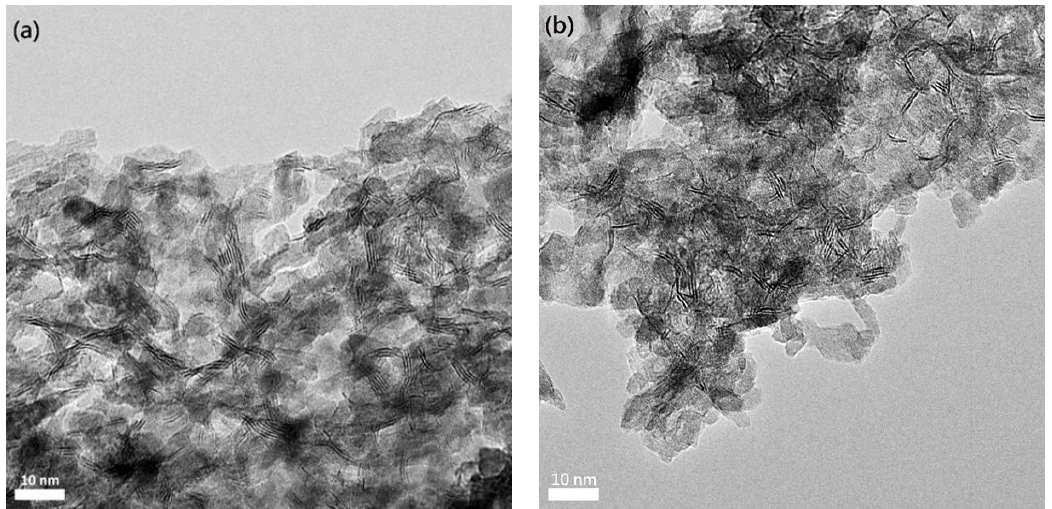
Figure 4. High-resolution transmission electron microscopy (HRTEM) images of mesoporous sulfide catalysts ( a ) CoMo/γ-Al 2 O 3 and ( b ) NiMo/γ-Al 2 O 3 .